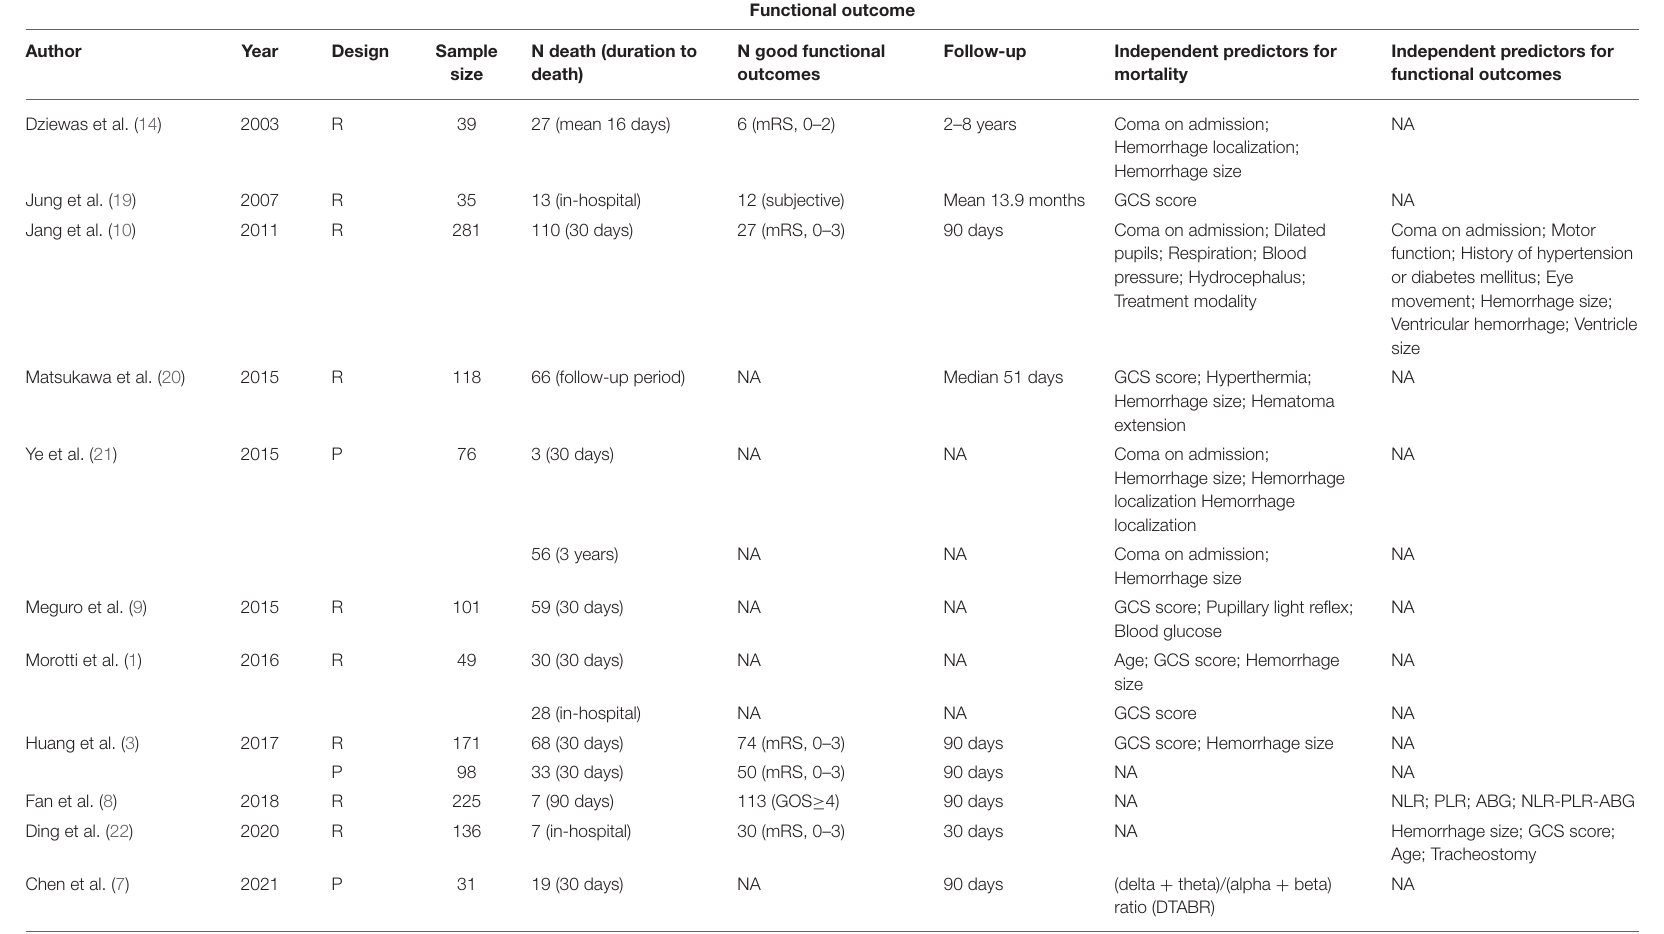
TABLE 1 | Researches that used multivariate logistic regression analysis to identify independent predictors for